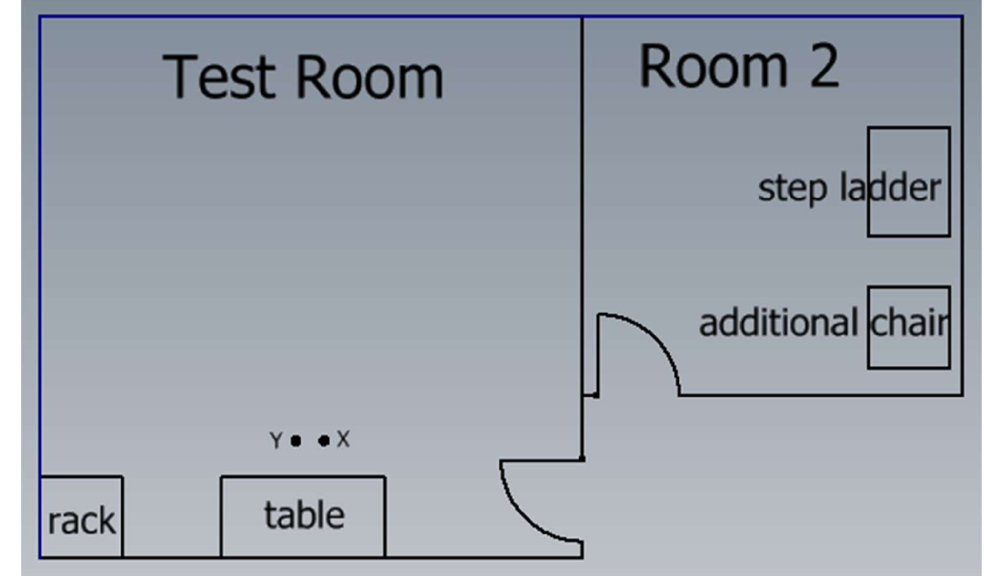
Figure 5. Illustration of test